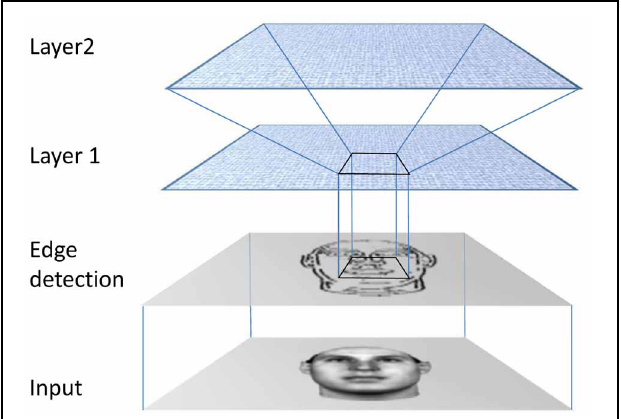
FIGURE 6 | The network processes the input image in three stages. The first stage performs edge detection. Output from this stage is then read by the first neural stage. Processing in this stage is localized such that a pool of interconnected neurons samples a corresponding patch of the edge-detected image. The final stage is Layer 2, which contains a single pool of interconnected neurons which all receive input from the entire array of Layer 1